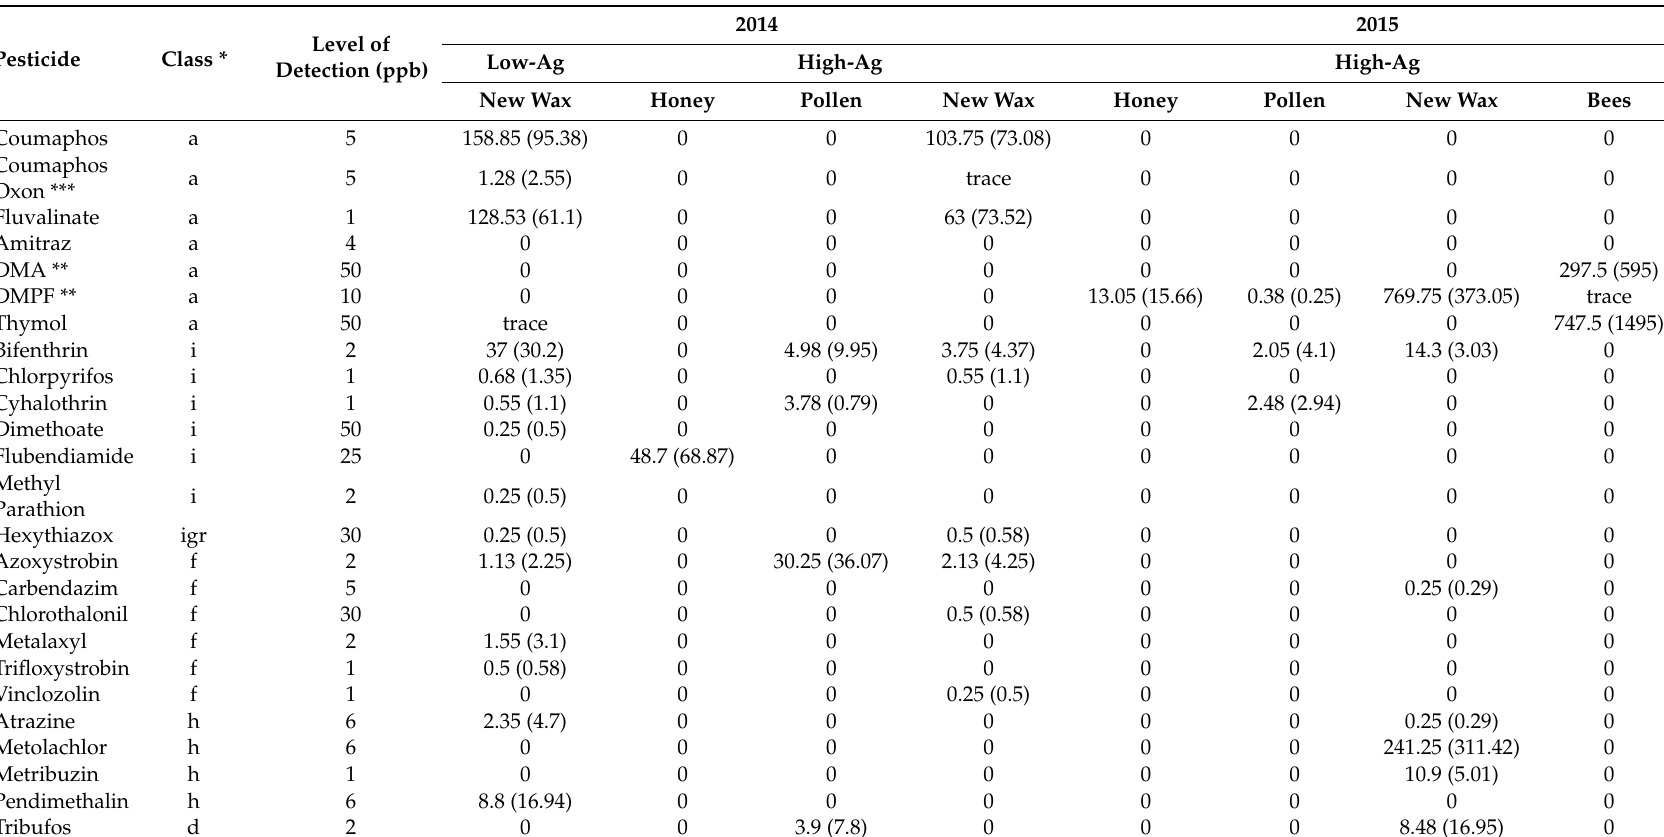
Table 5. Pesticide residues detected in hive products. Results are given in parts per billion (ppb, ± SE). Where results are reported as 0, compound was not detected. Where results are reported as “trace” the compound was detected, but at a level too low to be